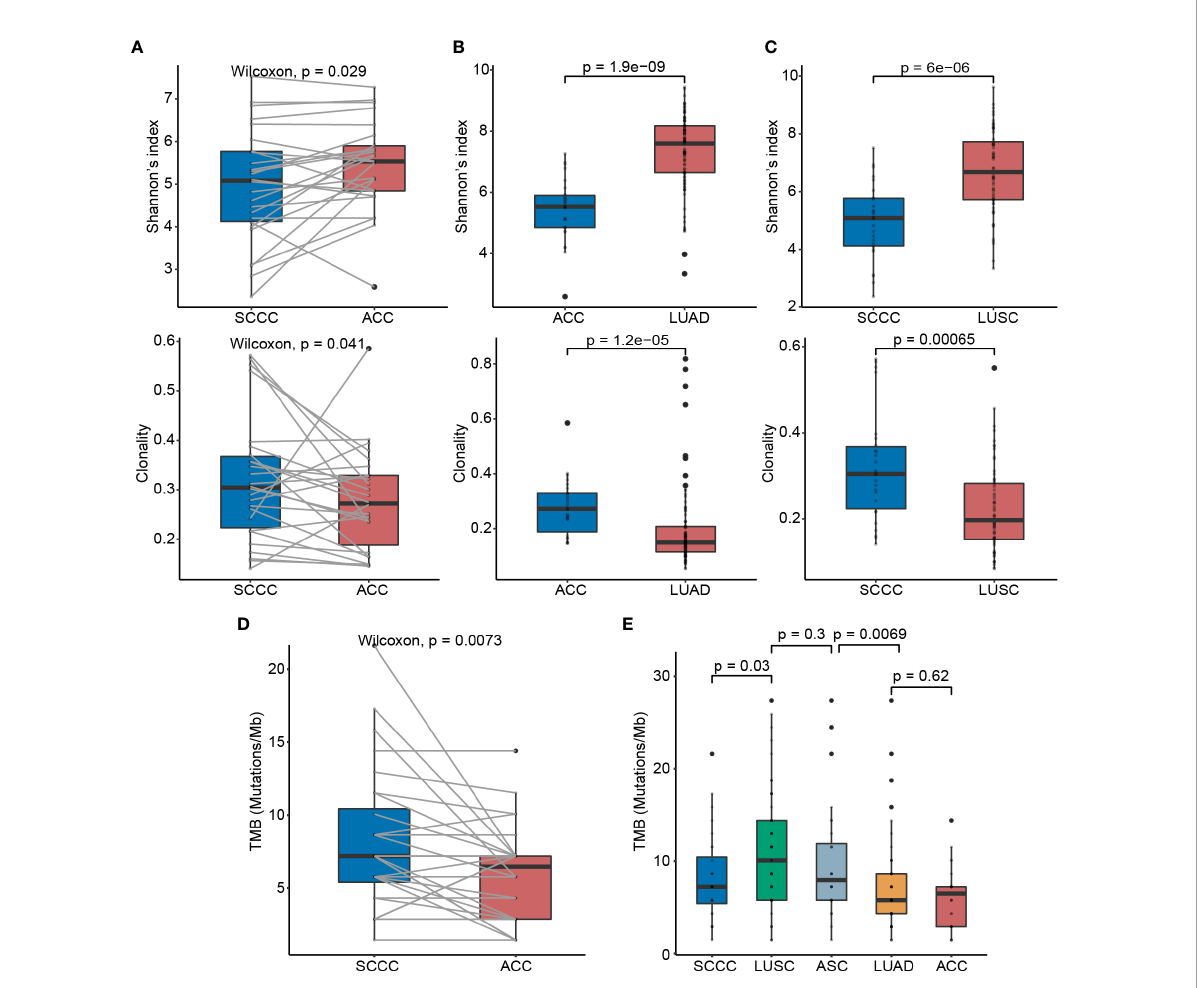
FIGURE 4 T-cell receptor (TCR) diversity and tumor mutation burden (TMB) status in lung adenosquamous carcinoma (ASC). (A) Comparisons of the TCR diversity and clonality between ACCs and SCCCs. Shannon ’ s index is employed to characterize tumor-resident T-cell diversity. TCR clonality re fl ects the potential clonal expansion of tumor-speci fi c T cells. Lower TCR diversity and higher TCR clonality in (B) ACCs versus pure LUAD and (C) SCCCs versus pure LUSC. (D) TMB discrepancy between ACCs and SCCCs. (E) TMB comparisons among ACCs, LUAD, SCCCs, LUSC, and